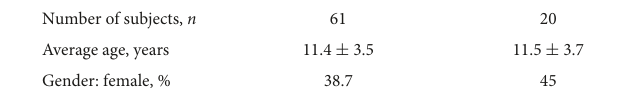
TABLE 2 Additional characteristics of the experimental group